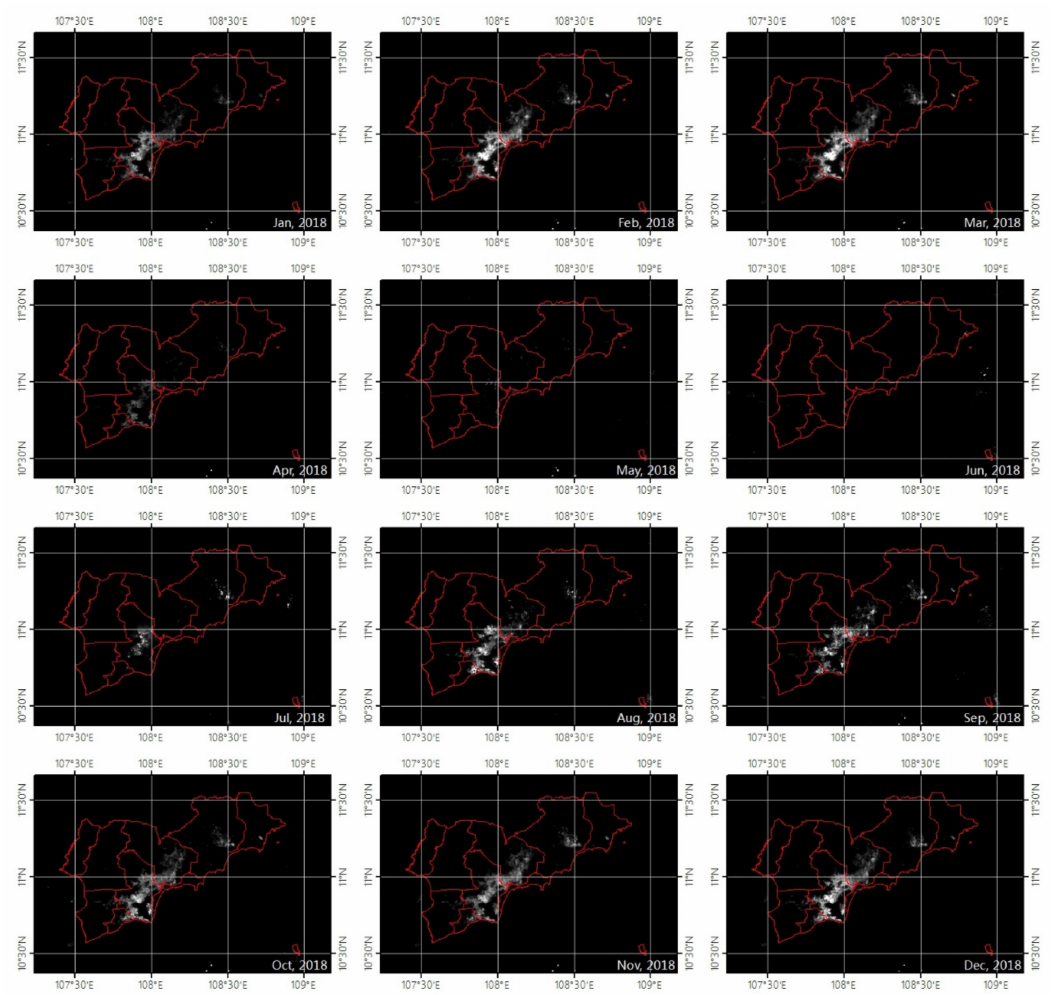
Figure3. NationalPolarPartnership(NPP)-VisibleInfraredImagingRadiometerSuite(VIIRS)nighttime light (NTL) monthly composite data of Binh Thuan Province from January to December